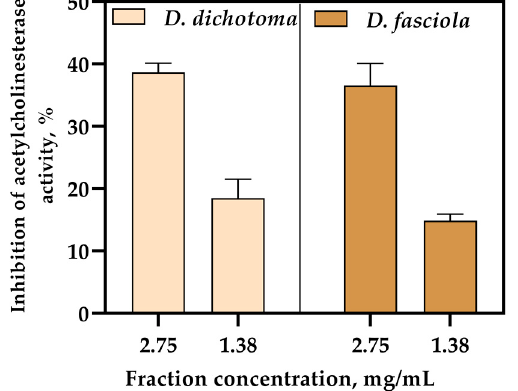
Figure 6. Acetylcholinesterase inhibitory activity of the D. dichotoma and D. fasciola fractions. Data are expressed as mean ± SD ( n = 3).